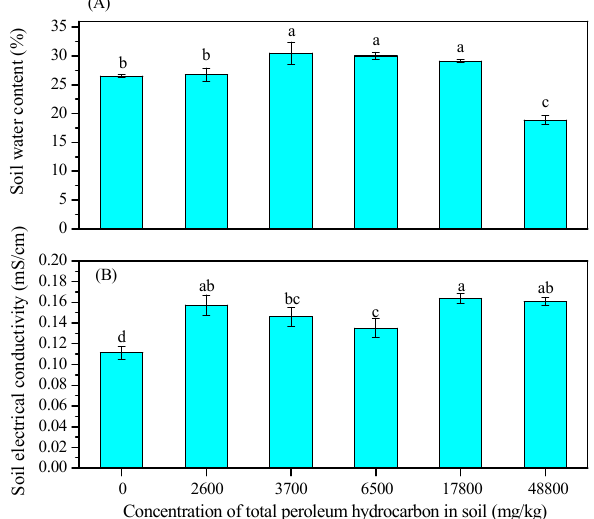
Figure 1. E ff ect of soil contamination with crude oil on soil water content ( A ) and soil electrical conductivity ( B ). ( p < 0.05). Di ff erent letters on top of the bar indicate they are significantly di ff erent at p < 0.05.